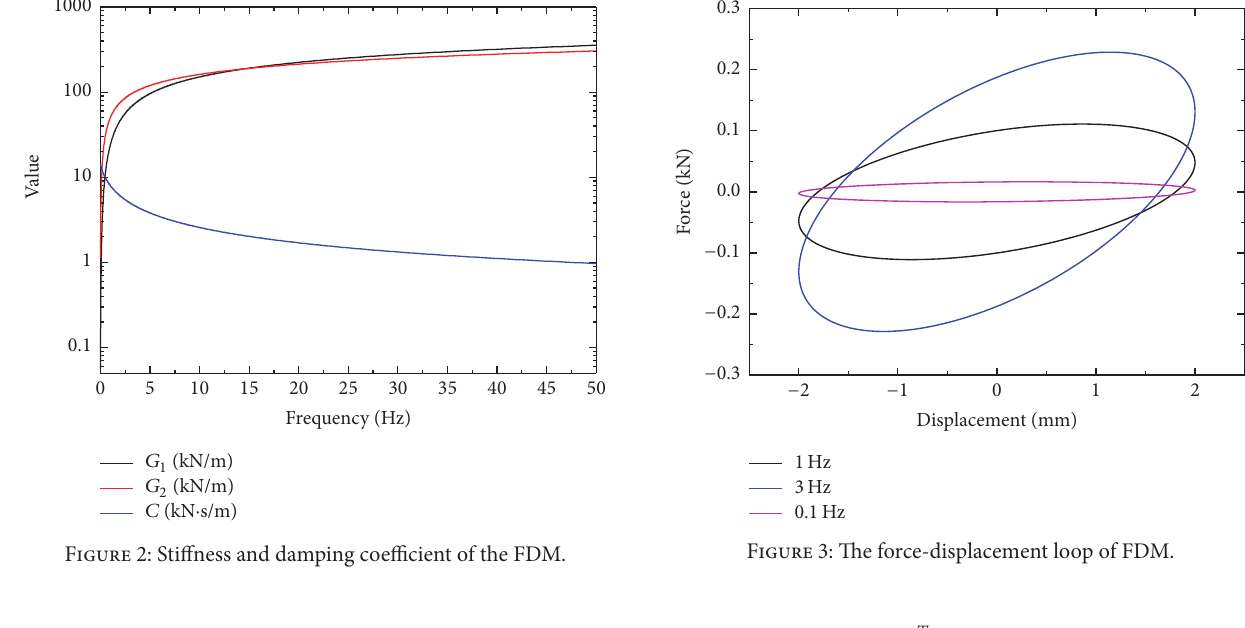
motion. The general mass, stiffness, and damping matrices [ M ] , [ K ] , and [ C ] in (8) are given by